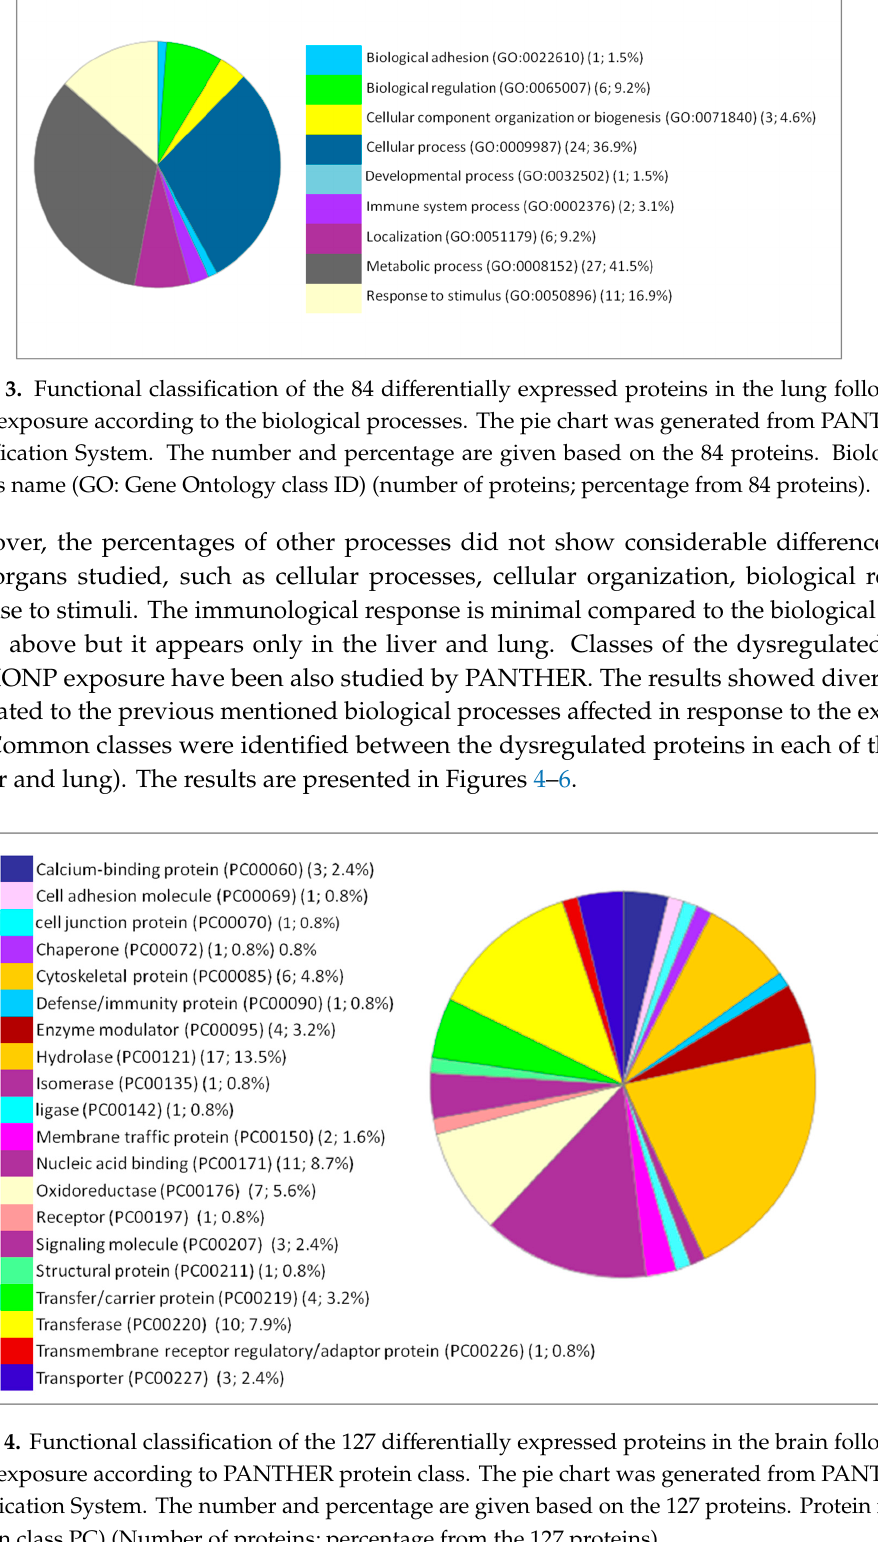
Figure 1. Functional classification of the 127 differentially expressed proteins in the brain following IONP exposure according to the biological processes. The pie chart was generated from PANTHER Classification System. The number and percentage are given based on the 127 proteins. Biological